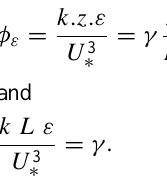
interval [ 0 . 5 − 0 . 6 ] . It appears that ε is a function of the ver- tical intercept of the regression line: ln (S u (κ)) = f ( ln (κ)) .